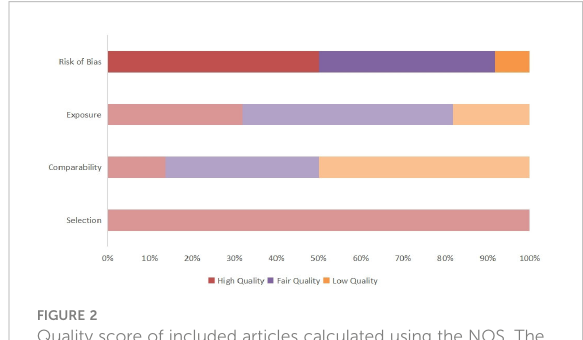
FIGURE 2 Quality score of included articles calculated using the NOS. The overall article quality score and risk of publication bias are obtained by calculating three